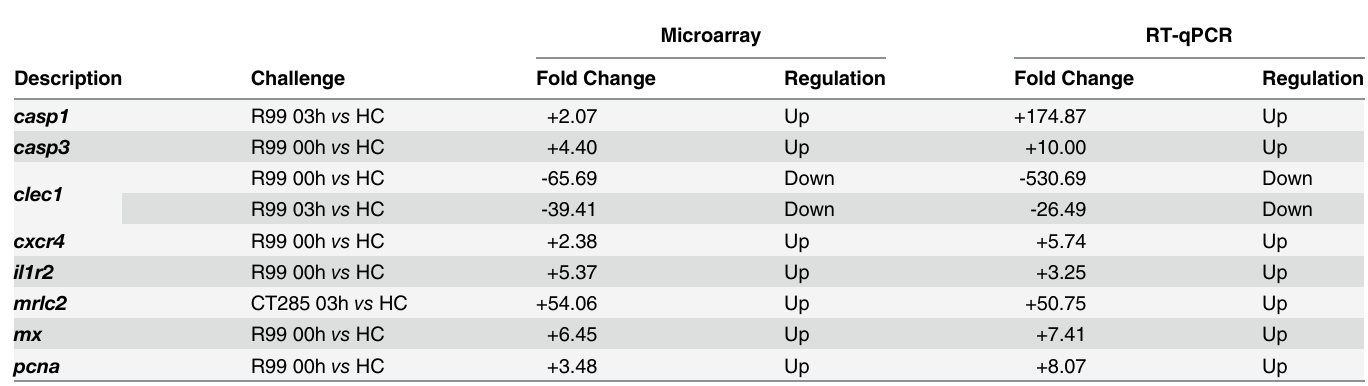
Table 5. Microarray validation analysis by RT-qPCR absolute quantification based on mRNA